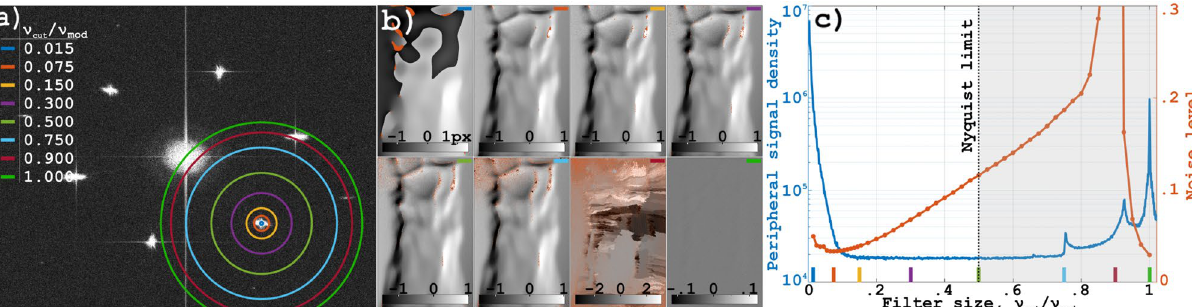
Figure 4. The effect of filter size on image quality. ( a ) The absolute value of the Fourier transform of the original image. The rings indicate the sizes of the filters used to reconstruct the signal in the Fourier cluster they are centered on. In the legend the filter specific ratio between its cut-off frequency and the modulation frequency is given. ( b ) Light displacement in pixels for different filter sizes. The colors in the upper right corners show the filter size, according to the legend in ( a ). ( c ) The measurement’s peripheral signal density, defined as the total signal at the (one pixel wide) filter edge divided by the area of the filter edge (blue line, left y-axis), and the noise level, defined as the average standard deviation of 10 000 random small areas ( 10 × 10 px), in images as those in ( b ), for 49 different filter sizes (orange, right